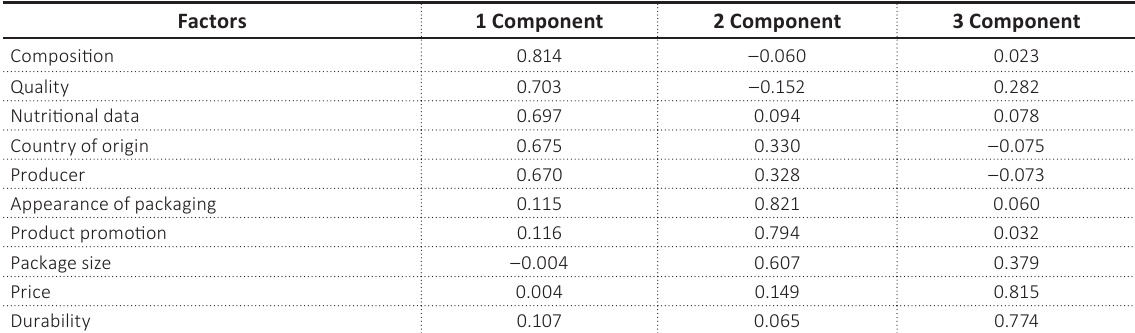
Table A6. Factor loadings from Categorical Principal Component Analysis (CATPCA)